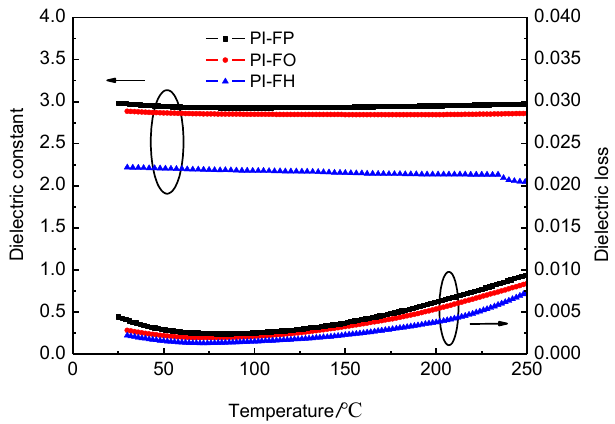
Figure 8. The temperature dependence of the dielectric properties at 10 4 Hz for PI films. Table 4. The dielectric parameters of PI films.